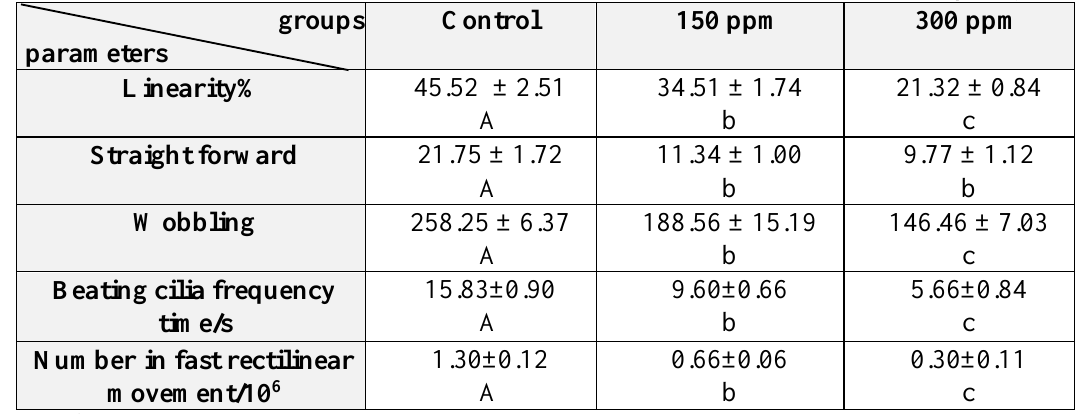
Table 5. Effects of different sub lethal concentrations of sodium fluoride on the movement of sperm, mean ± SE.